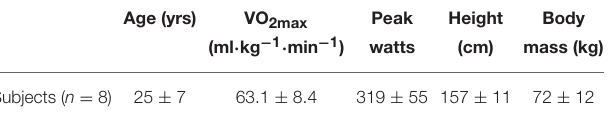
Frontiers in Physiology |